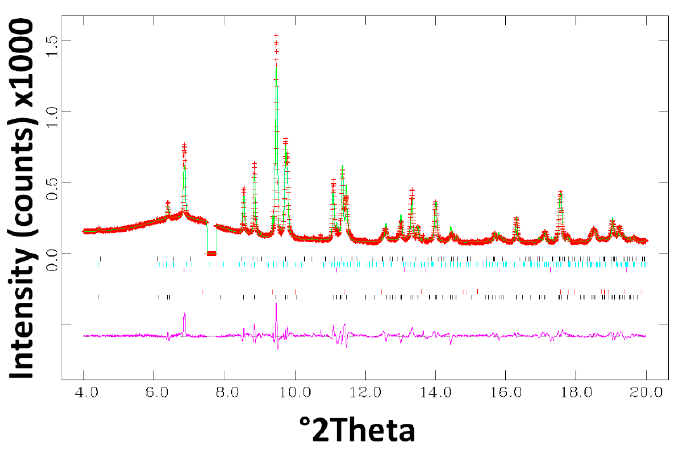
Figure 2. Graphical output of the Rietveld refinement of the bulk fibrous tremolite sample heated at 1000 °C. Legend: Red crosses = observed pattern; green line = calculated pattern; magenta line = difference curve. The markers plotted on five distinct rows correspond to the reflections of each phase in the model. Each row corresponds to a phase with diopside, calcite, cristobalite, clinoenstatite, and protoenstatite from the bottom to the top.